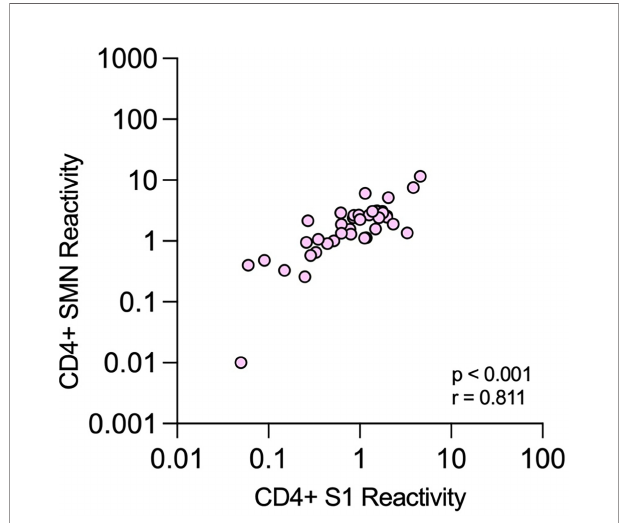
FIGURE 6 | Correlation between CD4 + T-cell reactivity against S1 and SMN peptide pools. Correlations between proportions of OX40 + CD25 + cells among all CD4 + T cells after stimulation with the two different peptide pools at time- point 4 in health care workers with veri fi ed